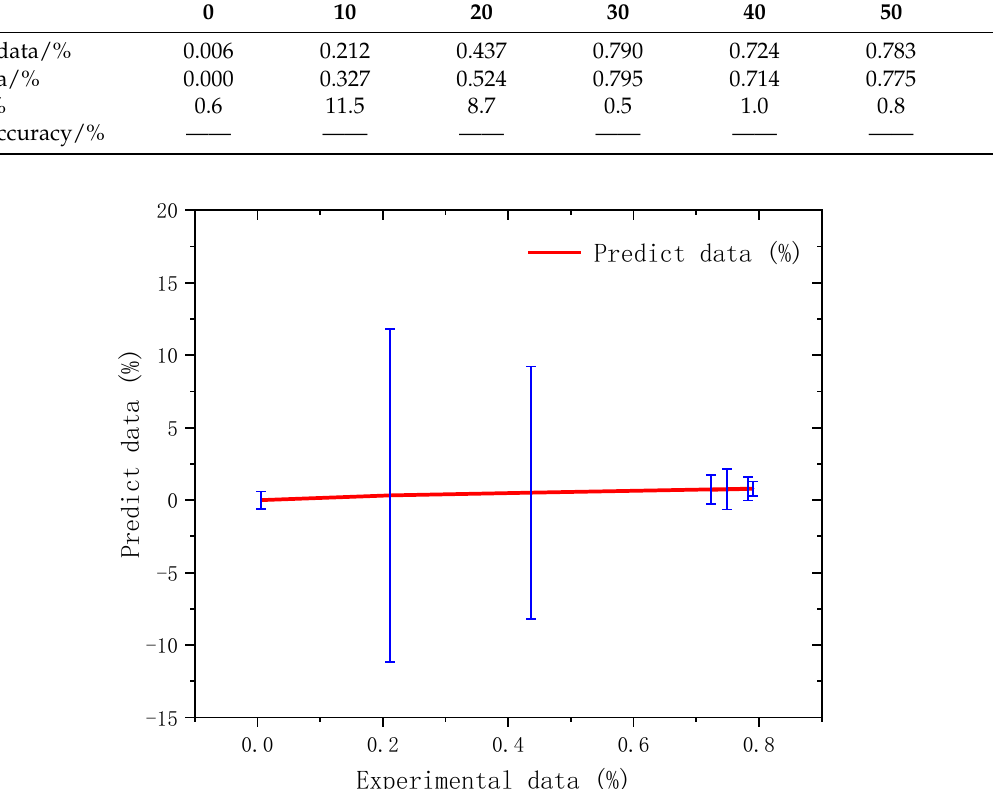
Figure 7. Error bars of BP neural network predictions. Table 4. Neural network prediction of elemental concentrations.